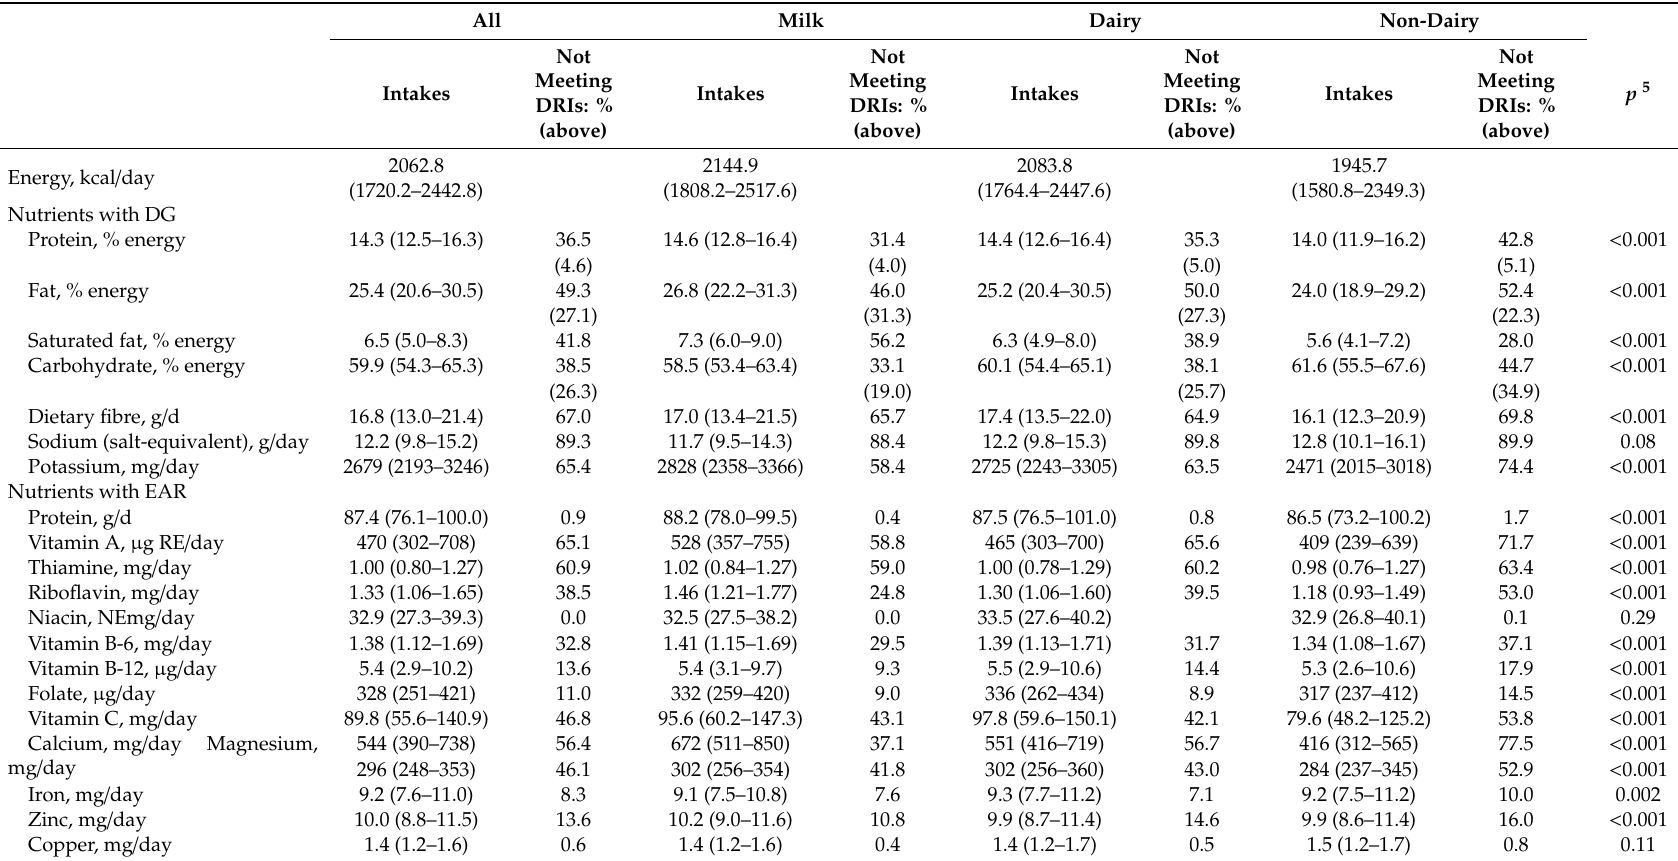
Table 4. Daily nutrient intakes and prevalence of not meeting DRIs (DG and EAR) among 9987 men according to dairy intake status